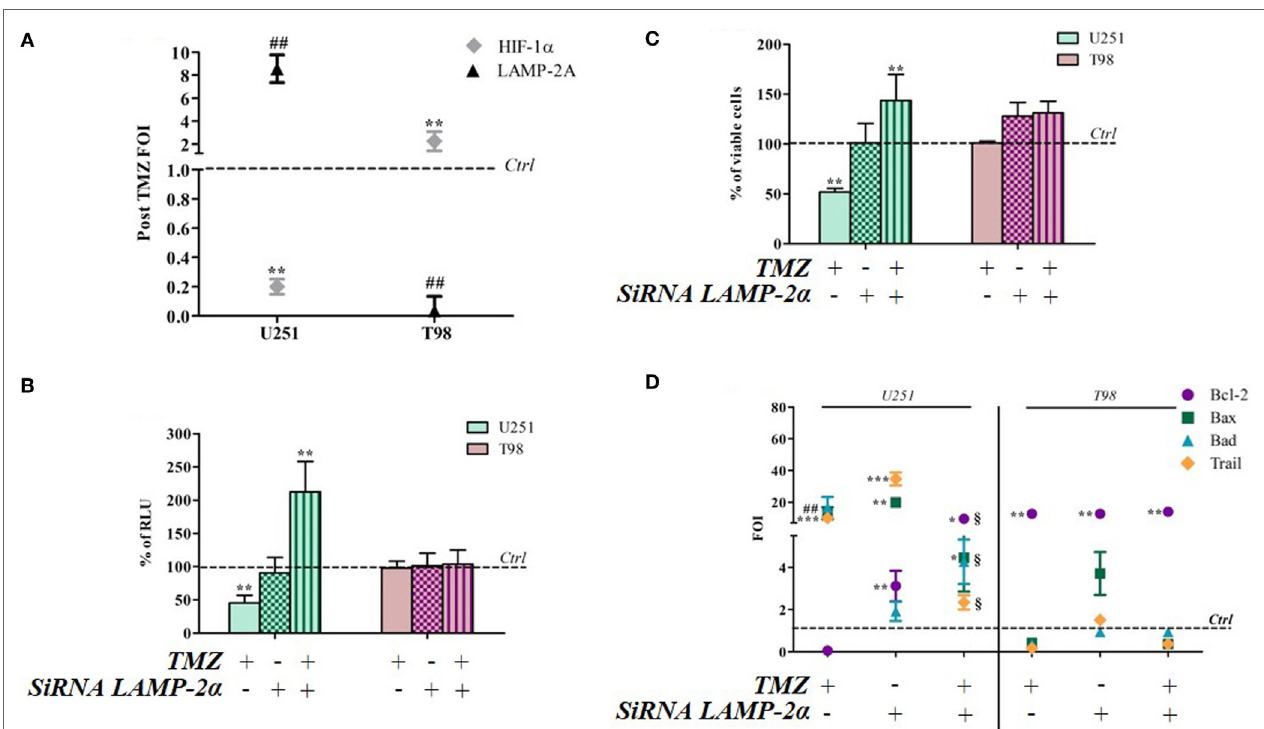
FigUre 5 | LAMP-2A silencing induces a resistant-profile in temozolomide (TMZ)-sensitive cells. (a) The expression of hypoxia-inducible factor (HIF)-1 α and LAMP-2A was measured in the U251 and T98 cell lines after TMZ treatment. The data were normalized to β -actin, and the ΔΔ Ct values were expressed as folds of induction (FOI). (B) After silencing, the cells were treated with TMZ and the induction of Bax , Bad , Trail , and Bcl-2 genes was analyzed by means of real-time PCR. The data were normalized to β -actin, and the ΔΔ Ct values were expressed as FOI of the ratio between treated and untreated cells. * p < 0.05; ** p < 0.01; *** p < 0.001 treated vs control cells; # p < 0.05; ## p < 0.01 siRNA LAMP-2A vs TMZ. 1 p < 0.05 siRNA LAMP-2A + TMZ vs TMZ. (c) The viability of U251 and T98 cells was assessed by means of Trypan blue exclusion test, and expressed as the percentage of viable cells after single or combined treatment ** p < 0.01 treated vs control cells. (D) HIF-1 α -dependent luciferase activity was analyzed in cell lysates and expressed as the percentage change in relative luminescence units (RLUs) ** p < 0.01 treated vs control cells. Mean values ± SD of three independent